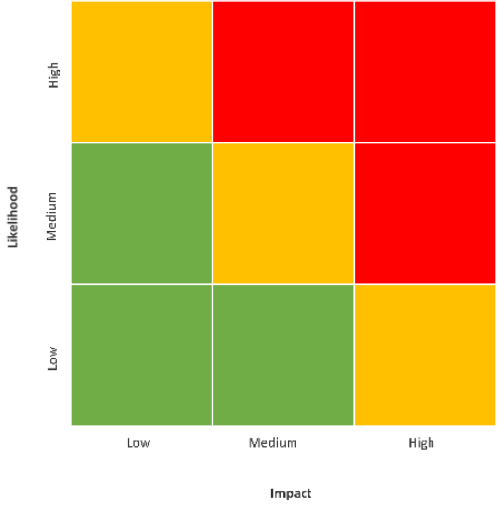
Figure 2. Risk matrix model.